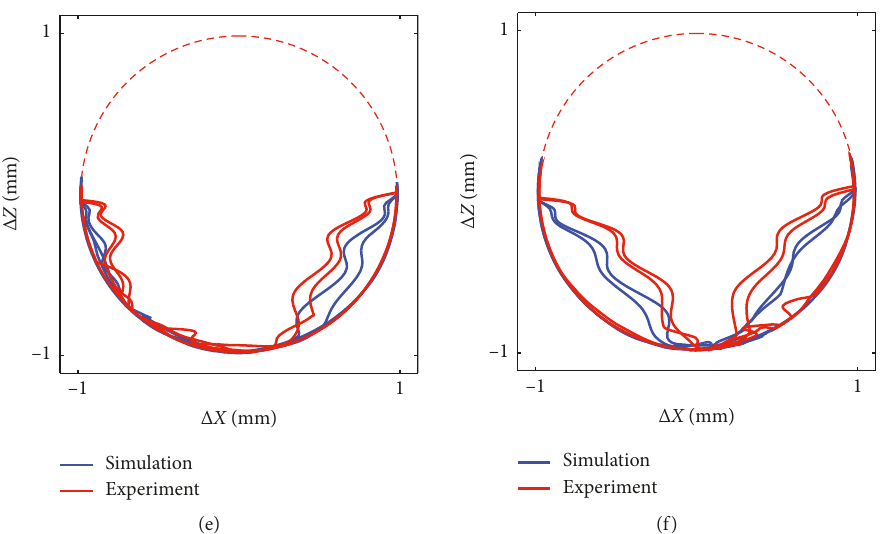
Figure 28: Trajectories in numerical and experimental studies with different c (c) left trajectories at c r � 0.5, (d) right trajectories at c r � 0.5, (e) left trajectories at c r � 1.0, and (f) right trajectories at c r � 1.0.